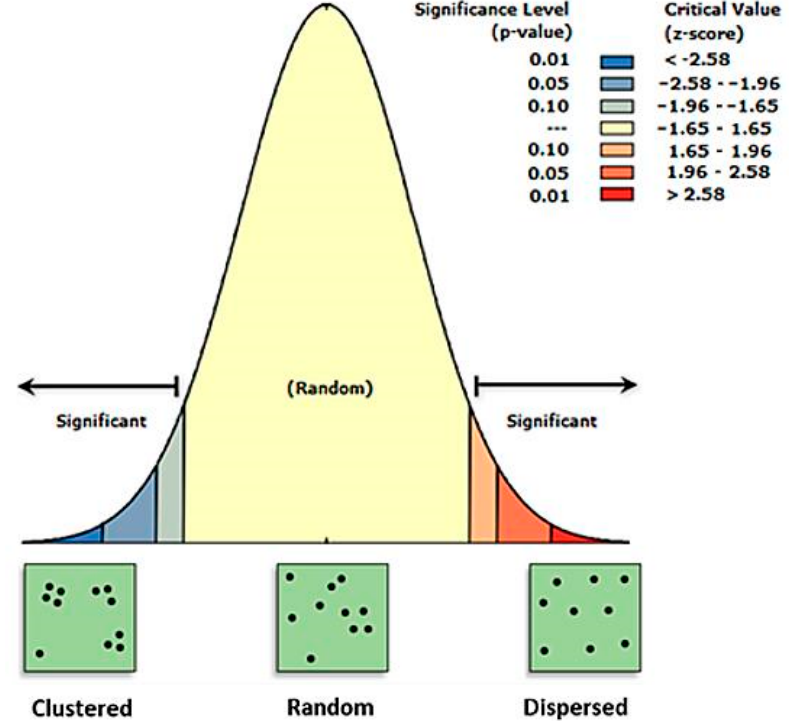
Figure 2. Average nearest neighbor analysis Source: Edited figure from Esri ArcGIS (https://desktop. arcgis.com/en/arcmap/10.3/tools/spatial-statistics-toolbox/average-nearest-neighbor.htm (ac- cessed on 13 January